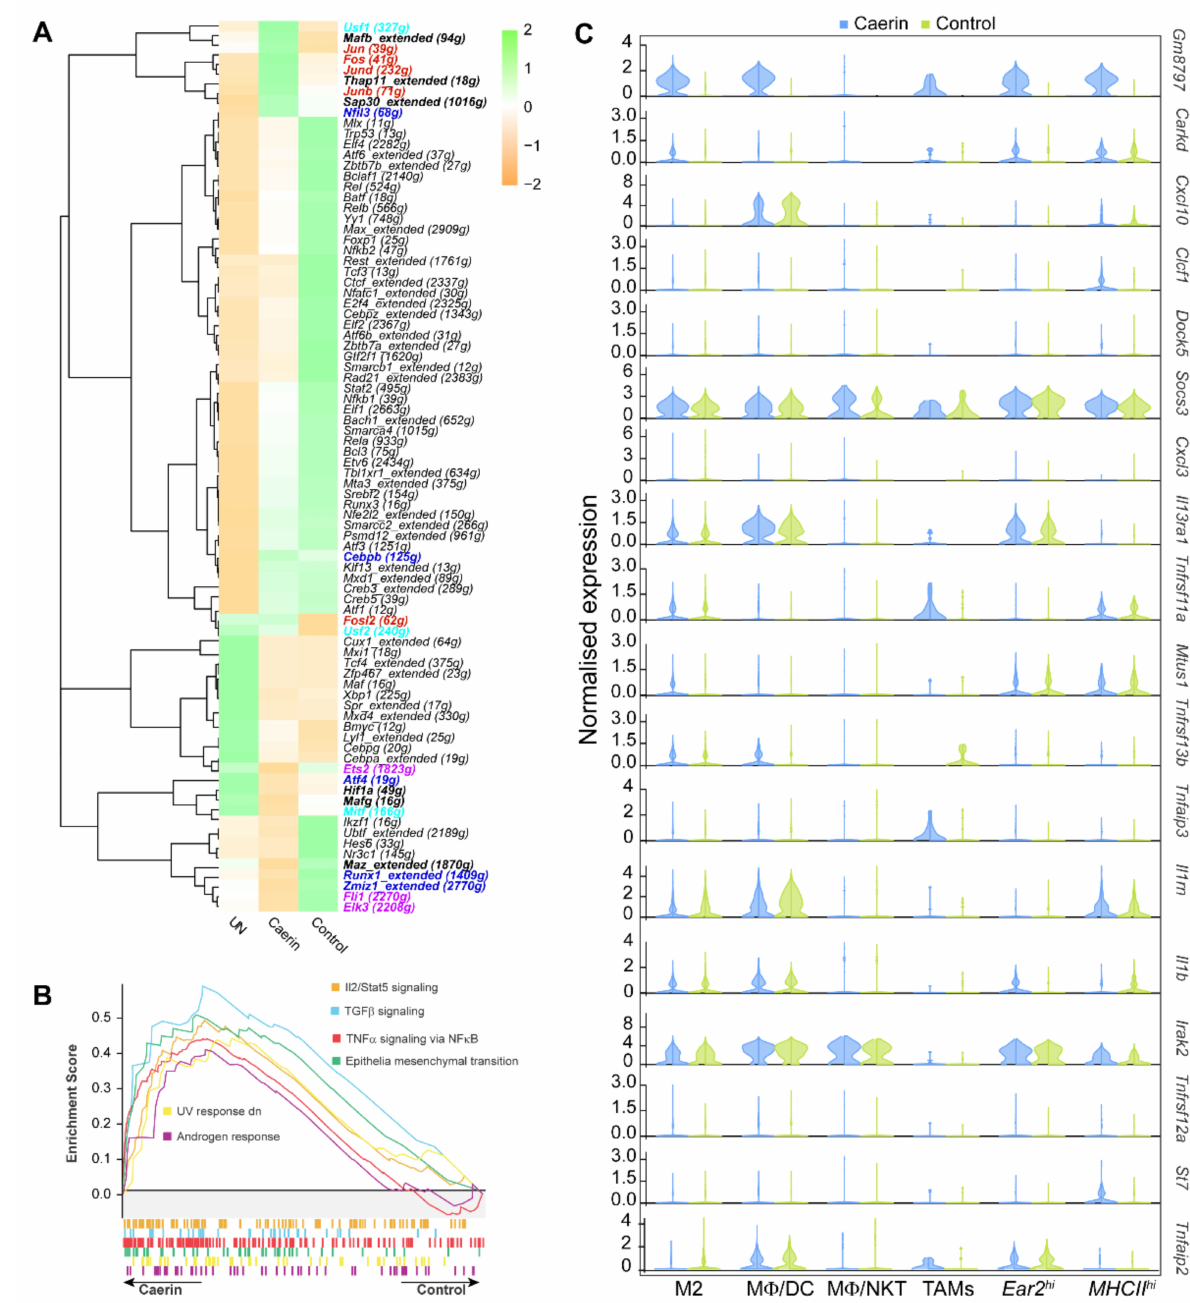
Figure 4. Regulation of M Φ populations following DT therapy with or without caerin. ( A ) SCENIC analysis of the significant transcription factors following different treatments; the bold font labels significantly regulated transcription factors in the caerin group. The analysis was performed based on the scRNA-seq data published previously [23]. ( B ) GSEA analysis of the Hallmark pathways enriched in the Ear2 hi M Φ s of the caerin group, relative to the control. ( C ) The top 18 immune response-relevant genes significantly regulated by treatment containing the caerin